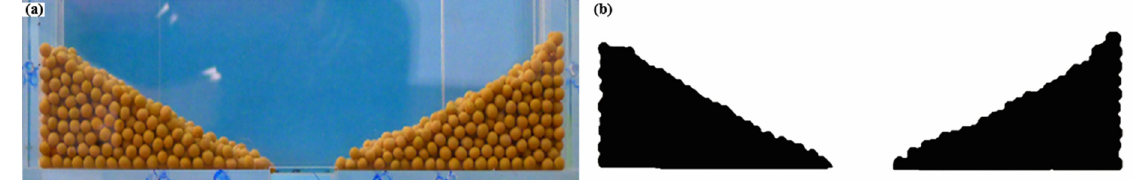
Figure 19. ( a ) Test photo of the piling angles and ( b ) its binarization image.